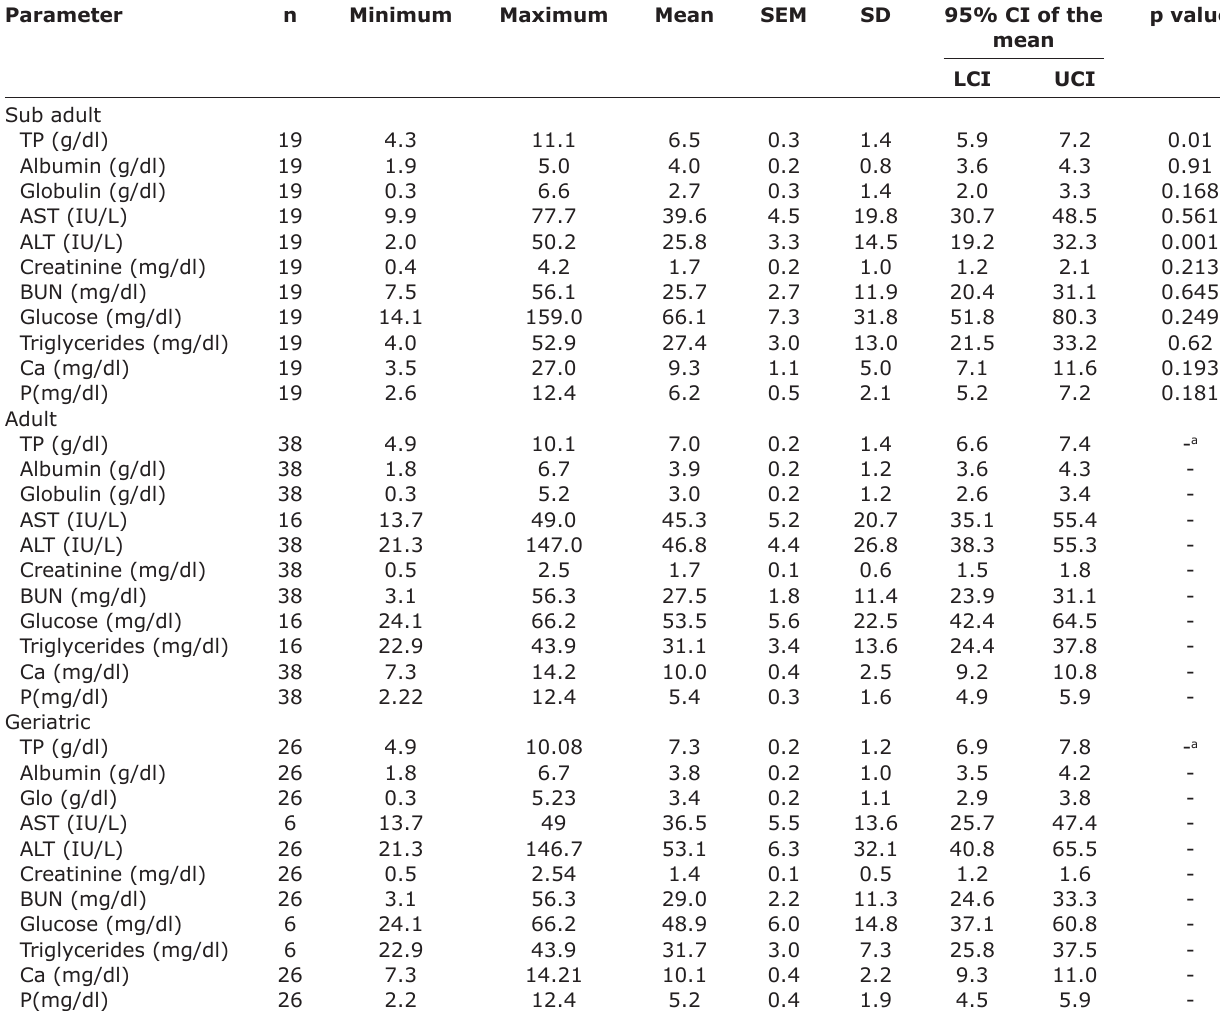
a p values for sub-adult, adult and geriatric group comparison are listed in the top (sub-adult) half of the table. TP=Total protein, AST=Aspartate aminotransferase, ALT=Alanine aminotransferase, BUN=Blood urea nitrogen, Ca=Serum calcium, P=Serum phosphorus, CI=Confidence interval, LCI=Lower confidence interval, UCI=Upper confidence interval, BBP=Bannerghatta Biological Park, MLRC=Manikdoh Leopard Rescue Center, SEM=Standard error of mean, SD=Standard